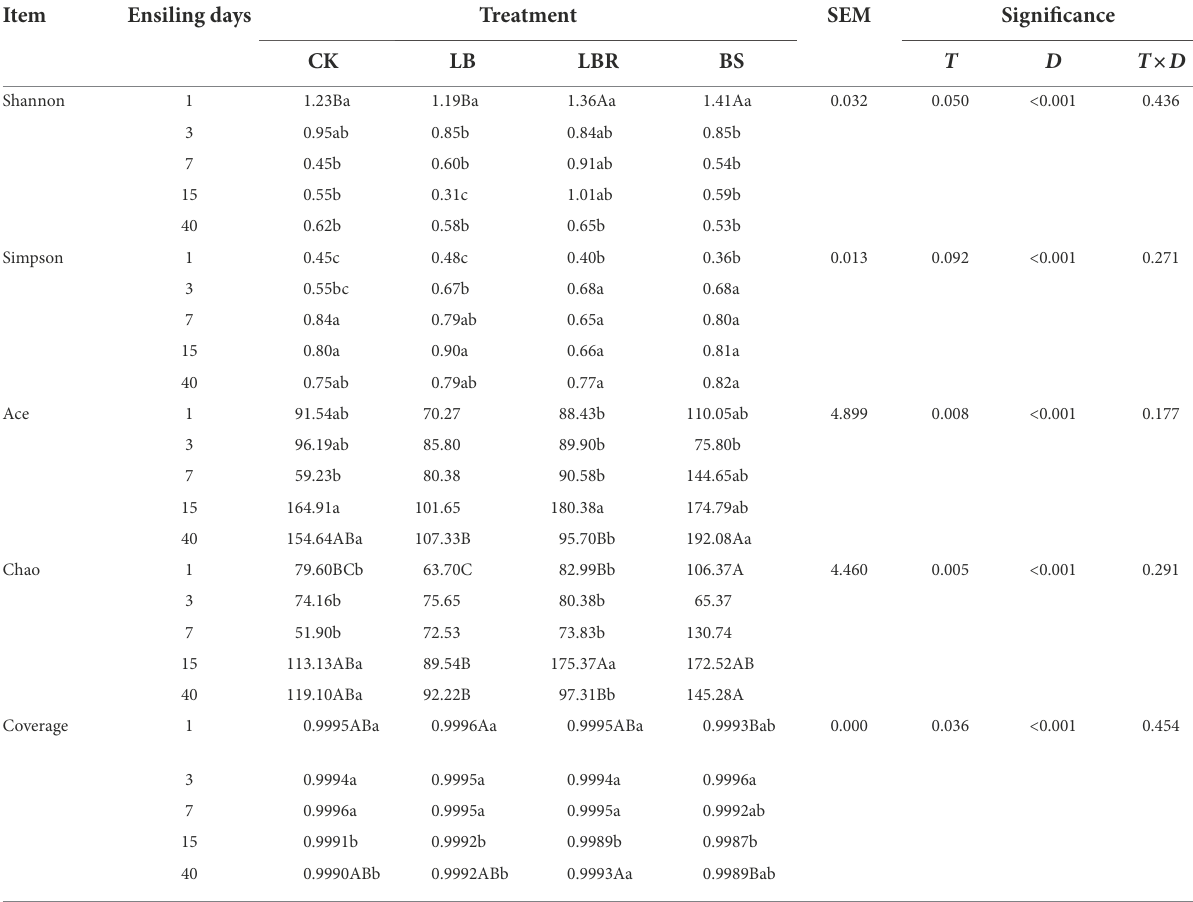
TABLE 4 Alpha diversity of bacterial diversity of sorghum-sudangrass